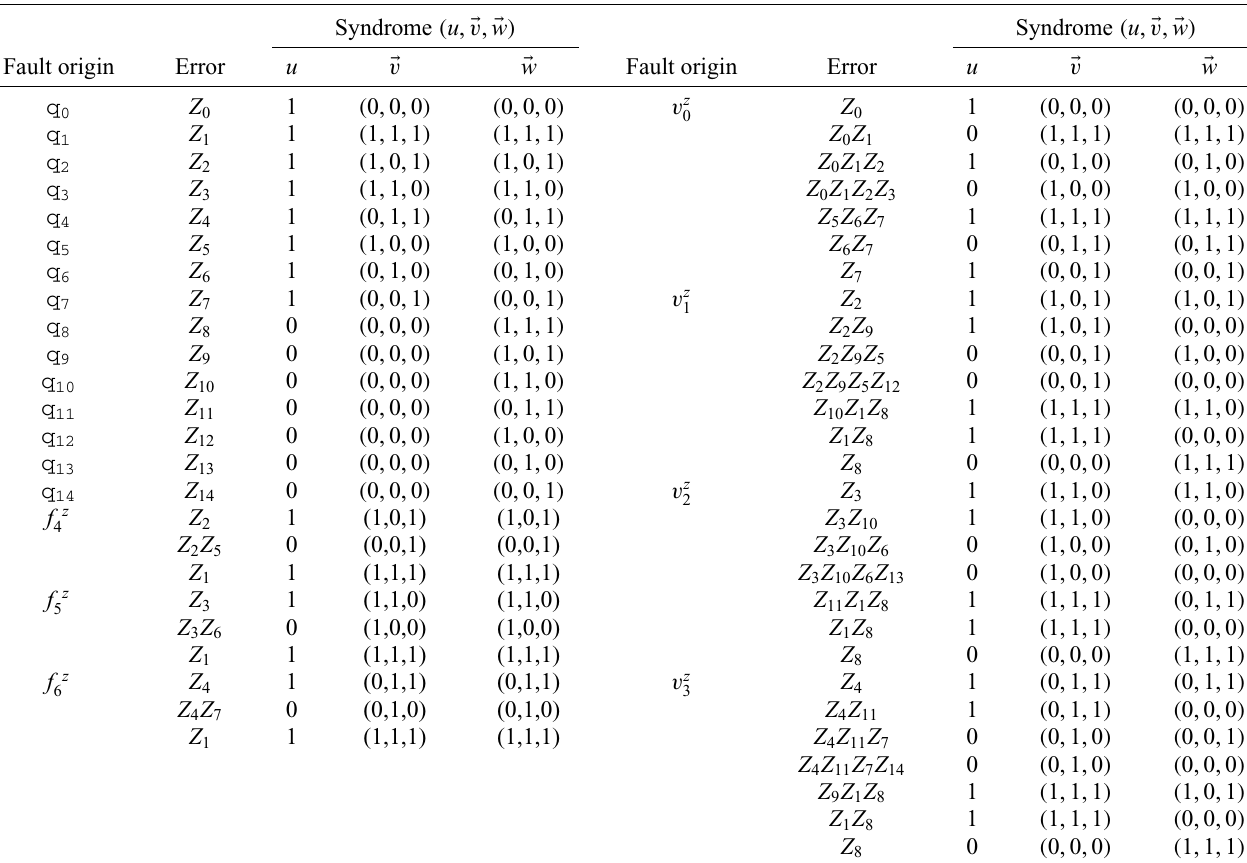
TABLE I. All possible Z -type errors arising from one fault and their syndrome corresponding to the CNOT orderings in Fig. 4. Any pair of possible Z -type errors on the list either have different syndromes or are logically